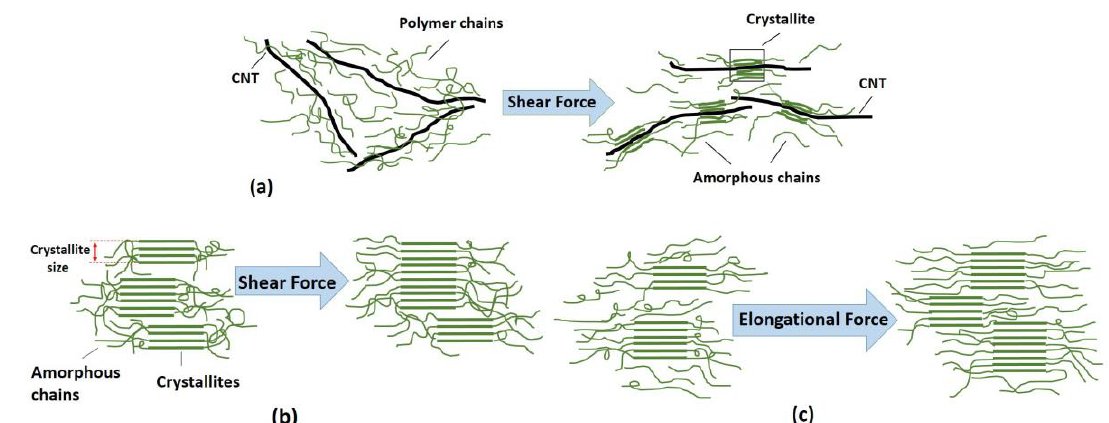
Figure 8. Schematics showing ( a ) possible mechanism for the e ff ect of shear force on the interface between polymer and CNT, ( b ) the e ff ect of shear force on crystallite size of PAN and PAN / CNT fibers, ( c ) the e ff ect of elongational force on crystallite size and crystallinity of PAN fibers.